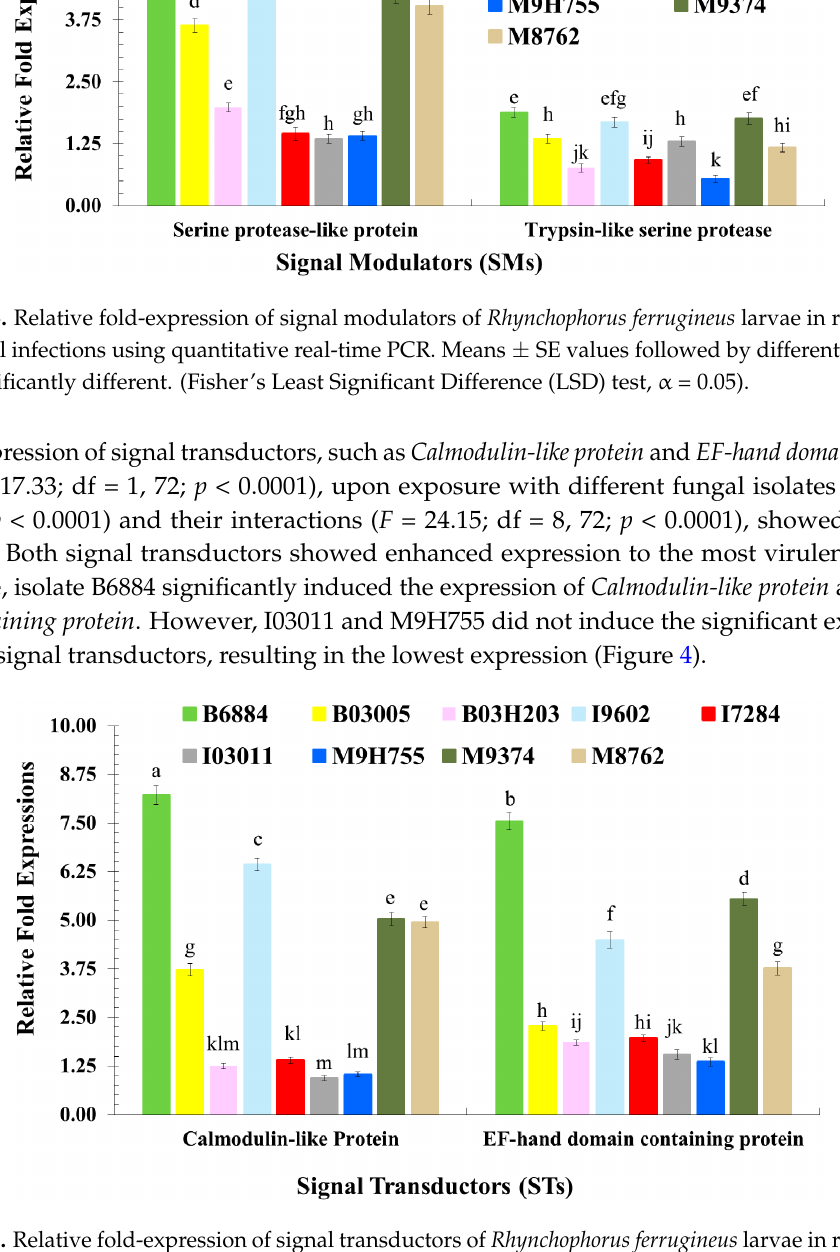
(Figure 3) The gene expression of the studied signal modulators ( F = 1071.42; df = 1, 72; p < 0.0001), upon exposure to different fungal isolates ( F = 129.87; df = 8, 72; p < 0.0001) and their interactions ( F = 45.73; df = 8, 72; p < 0.0001), showed significant differences. Comparatively, serine protease-like protein was significantly expressed compared with trypsin-like serine protease (Figure 3). Overall, the